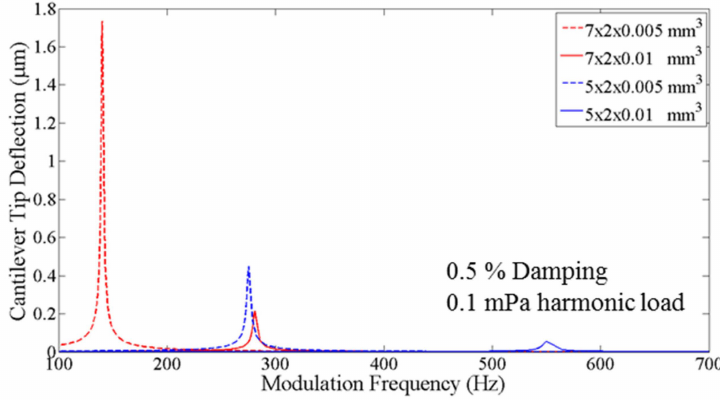
Figure 1. CoventorWare ® simulation results showing the effect of increasing cantilever length. In both the 5 µ m thick beams and 10 µ m thick beams, increasing the length from 5 mm to 7 mm resulted in approximately a 4 ˆ increase in cantilever tip deflection and sensitivity.